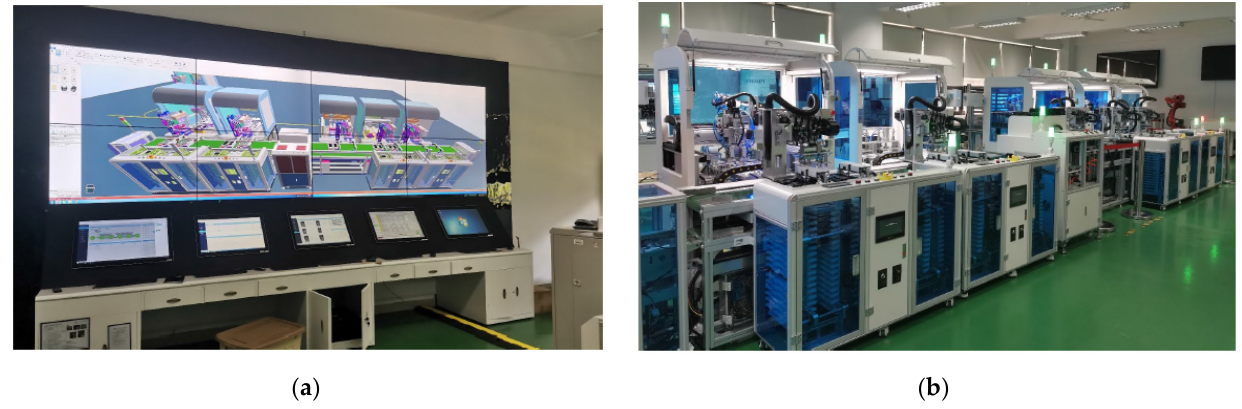
Figure 11. Mobile phone assembly line. ( a ) Virtual Simulation Platform. ( b ) Physical assembly line.